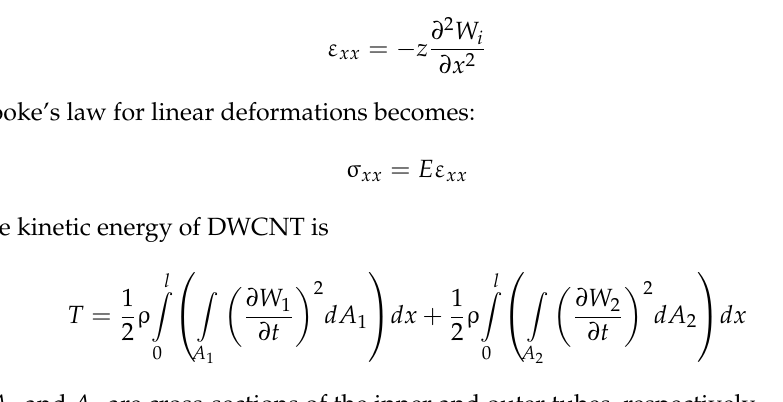
where A 1 and A 2 are cross-sections of the inner and outer tubes,